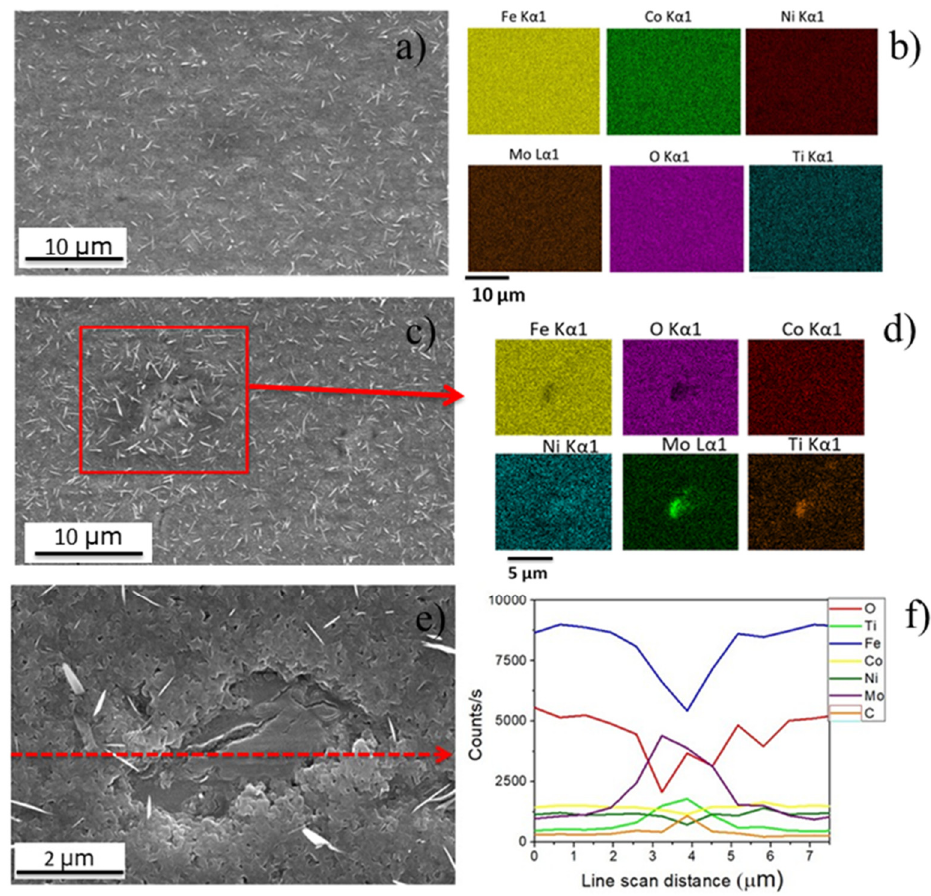
Figure 6. ( a , c , e ) Scanning electron microscope (SEM) micrographs (of the oxide produced on maraging 300 alloy) of the analyzed surface, ( b , d ) Energy-dispersive X-ray spectroscopy (EDS) chemical maps and ( f ) chemical elements profiles conducted on the through the red dash line of the Figure 6e.